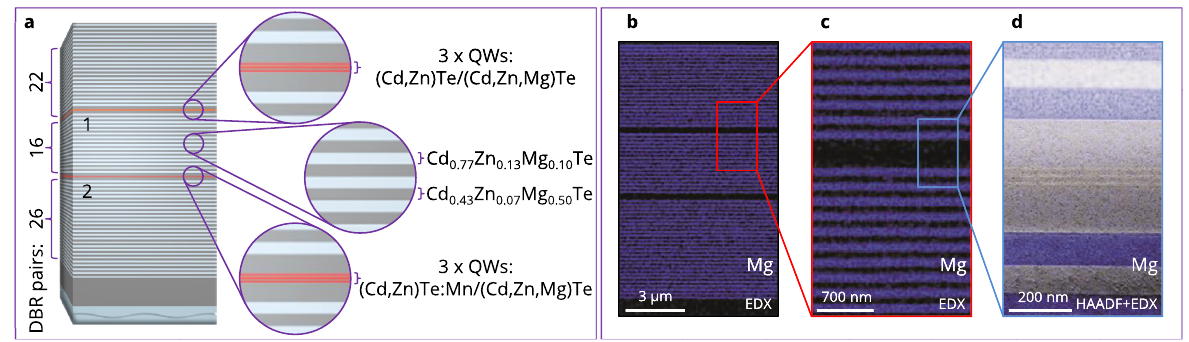
Figure 1: (a) Sketch of a vertically coupled, double microcavity structure. The top and the bottom microcavities contain a set of three (Cd,Zn)Te or (Cd,Zn)Te:Mn QWs, respectively. (b) and (c) Cross-sectional energy-dispersive X-ray spectroscopy (EDX) images of the sample showing the spatial distribution of magnesium, the content of which controls the energy bandgap and refractive index of the layers. (d) A high angle-annular dark-field scanning transmission electron microscope image with EDX compositional mapping of magnesium in the region of the microcavity with three QWs